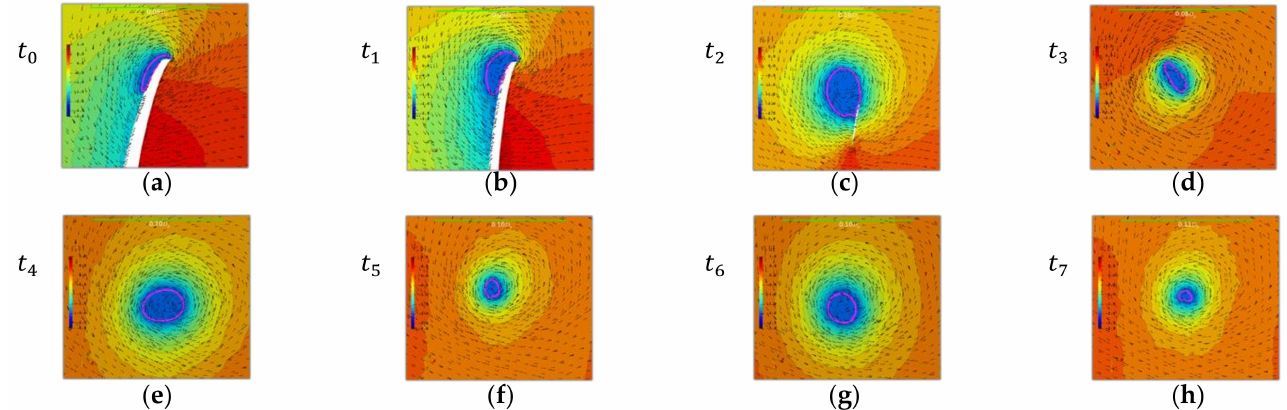
Figure 6. PPTC’11. ( a – h ) Relative velocity plots with pressure contours in helix-normal plane at stations t 0 – t 7 , respectively, with phase interface in magenta.